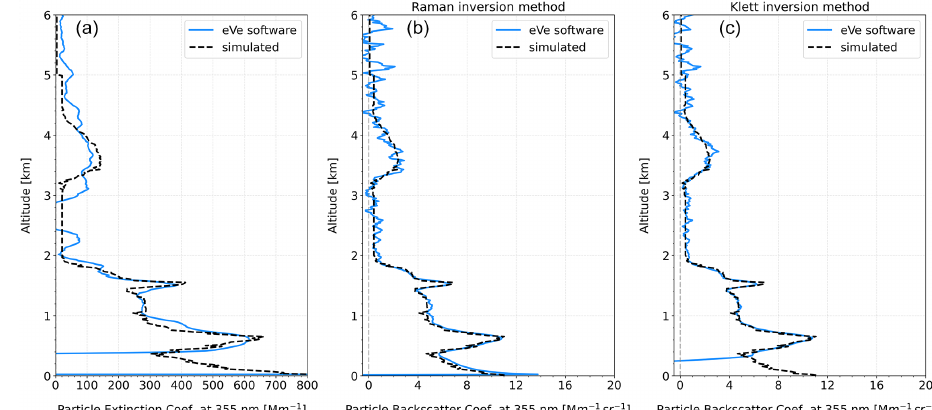
Figure 7. Comparison of the extinction coefficient profile (a) and the backscatter coefficient ( b and c ) at 355nm retrieved from the eVe software (solid; blue) and the simulated profile (dashed; black). The backscatter profile was retrieved using both the Klett (b) and the Raman (c) inversion method, where the reference height for Rayleigh atmosphere was selected at 6.5km with a 0.5km window. Table 1. Mean bias (MB) and root mean square error (RMSE) of the particle extinction and backscatter coefficients for three altitude ranges. The mean value of the simulated particle extinction and backscatter coefficient profiles inside the three altitude ranges is also provided. Particle extinction Particle